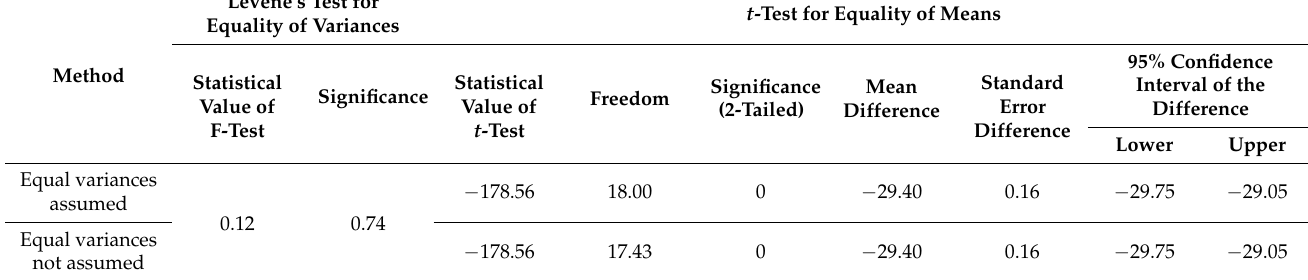
Table 7. t -Test result of gloss.